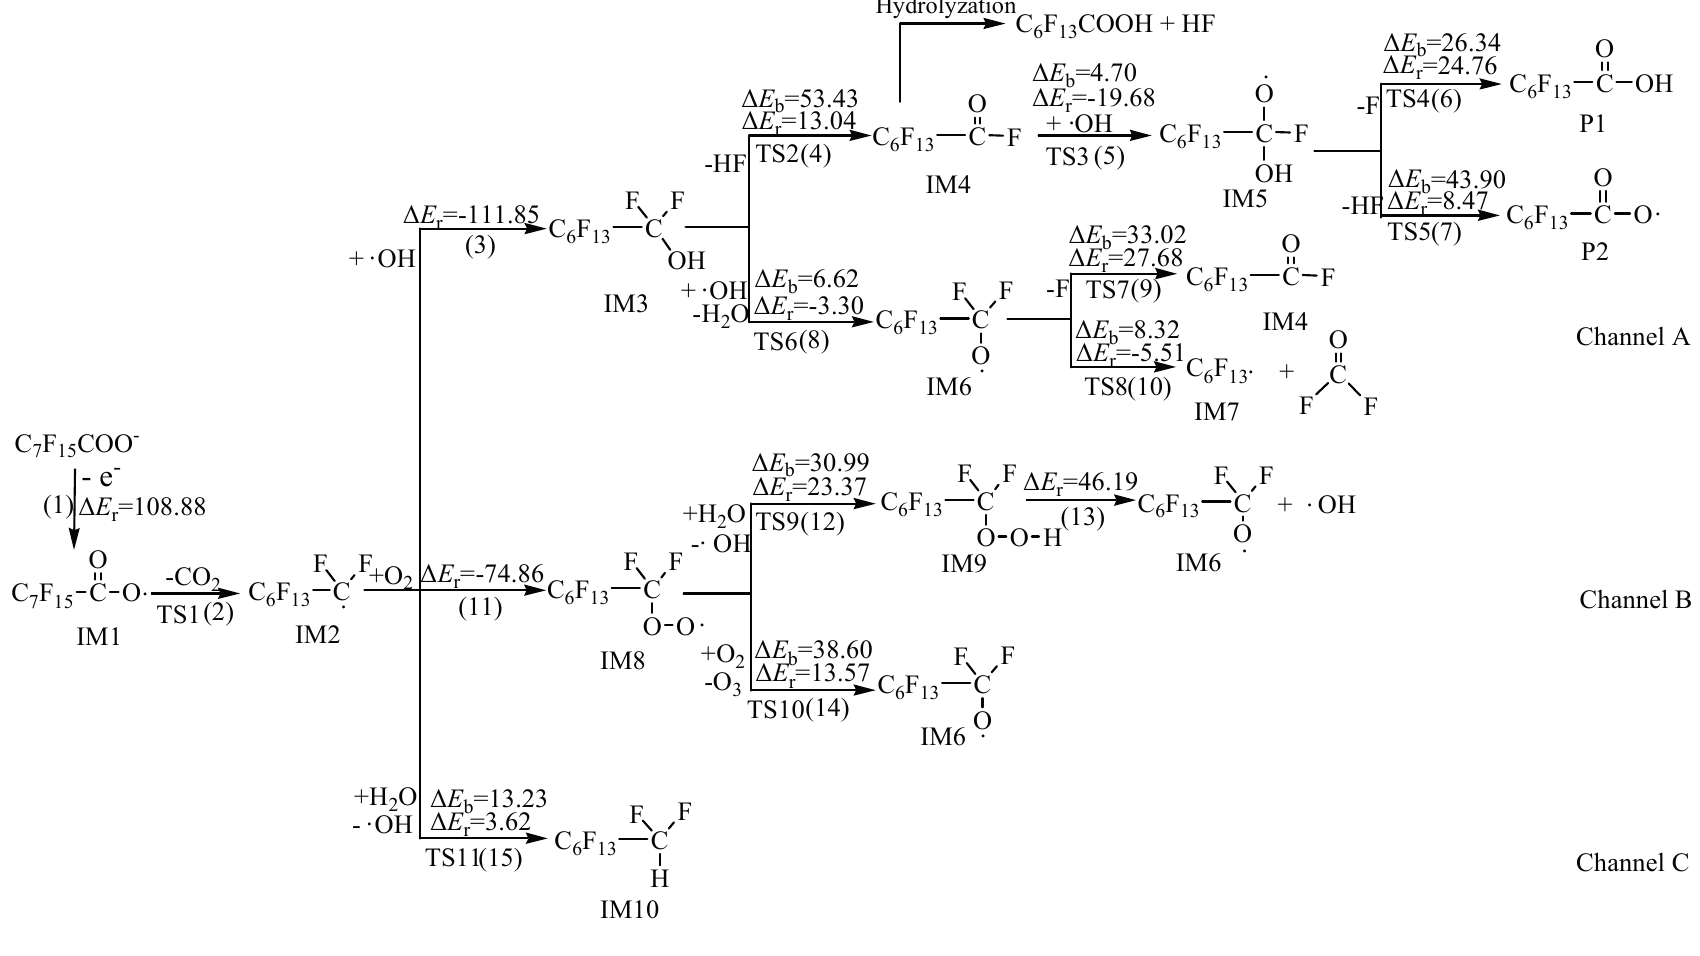
Figure 1. The main possible reaction paths of electrochemical degradation of PFOA embedded with the potential barriers Δ E reaction heats Δ E (kcal·mol − 1 r